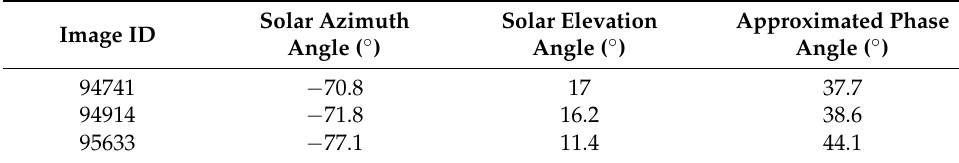
Table 4. Illumination conditions of the images used in the